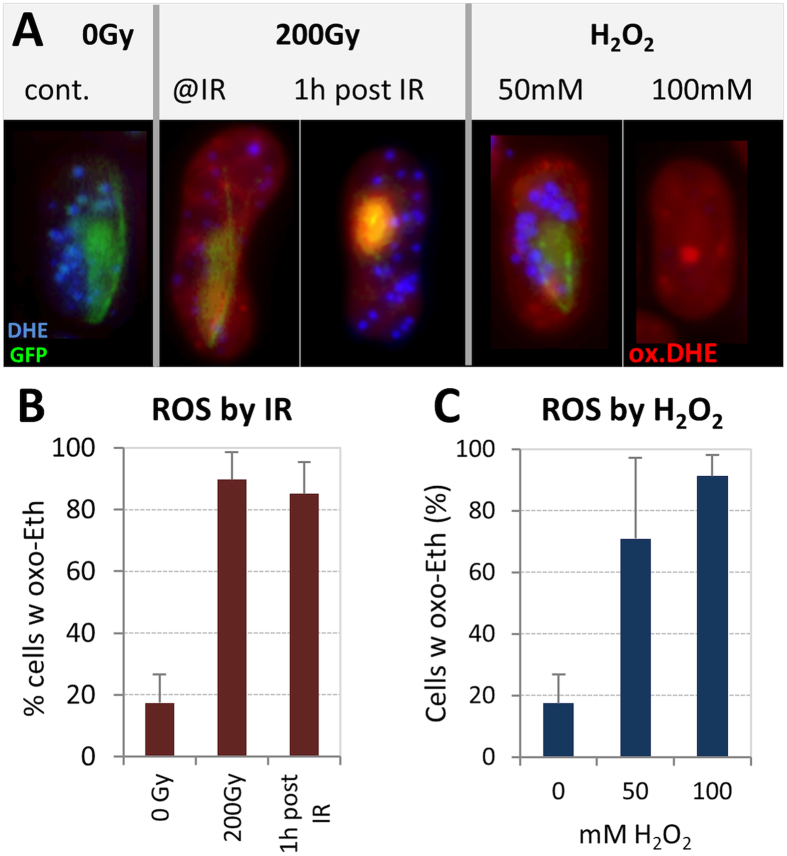
Analysis of the formation of reactive oxygen species (ROS) in irradiated Rec8-GFP expressing horsetail cells by di-hydroethidium (DHE, blue) staining.ROS exposure converts DHE to oxidized ethidium (oxo-Eth, red). Image recording was normalized by addition of fluorescent TetraSpecks. (A) Control cell (0 Gy) with a Rec8-GFP tagged (green) nucleus showing blue reduced DHE accumulations in the cell. 200 Gy: X irradiated cell displaying oxidized DHE (ethidium, ox.DHE; red) in the entire cell, while the nucleus appears reddish due to ethidium binding to DNA. Cell 1 h post IR still showing slight red cytoplasmic labelling, while the nucleus appears orange due to colocalization of green Rec8-GFP and red Ethidium (ox.DHE). Still, non-oxidized blue DHE aggregates can be seen. H2O2: Cells treated with H2O2 showing cytoplasmic red ROS labelling and a green horsetail nucleus at 50 mM H2O2, while 100 mM H2O2 quenched any endogenous fluorescence except for the red ethidium (ox.DHE) label. The red dot represents an unknown ethidium-affine structure in the cytoplasm. For a split channel display of the images see Suppl. Fig. S2. (B) Irradiation induces persistent ROS in 90% of 200 Gy-irradiated cells. (C) H2O2-induced ROS – a dose of 100 mM renders values similar to 200 Gy X irradiation.